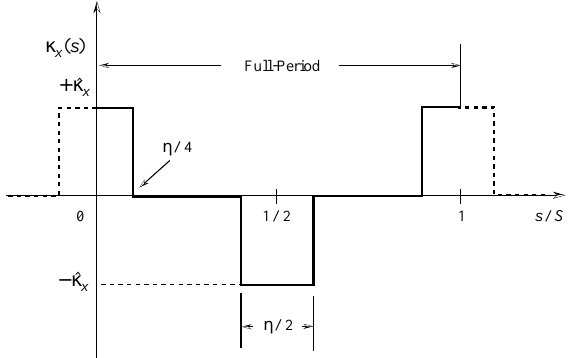
FIG. 4. Plot of lattice function k x (cid:1) s (cid:2) versus s (cid:3) S for a periodic step-function lattice with amplitude ˆ k x (cid:1) const and filling fac- tor h .